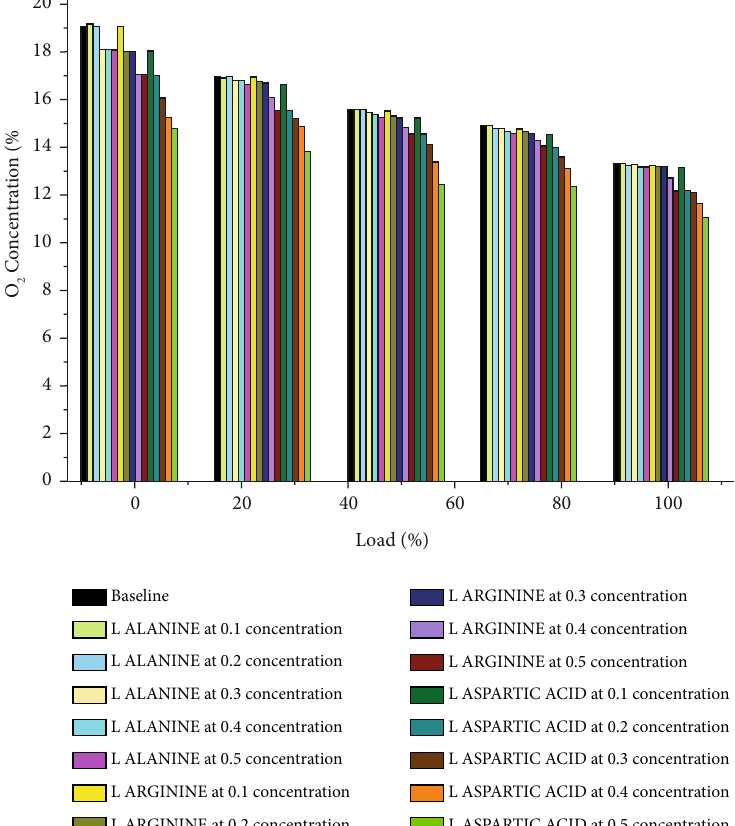
Figure 13: The di ff erence in O